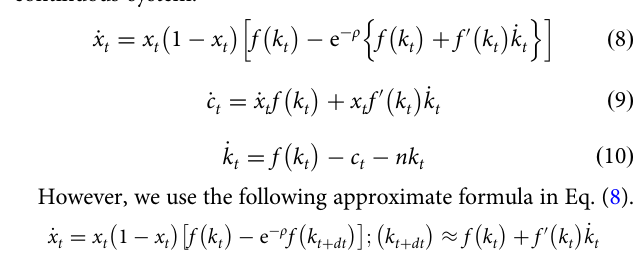
Procedure 3: Action. Next, based on the difference between the intertemporal allocation ratios x t and x t + 1 of production derived in Procedure 2 and the difference between the actual production value f ( k t ) for the current period and the planned production value f ( k t + 1 ) for the next period, the household formulates a revised consumption plan c t + 1 from the current period to the